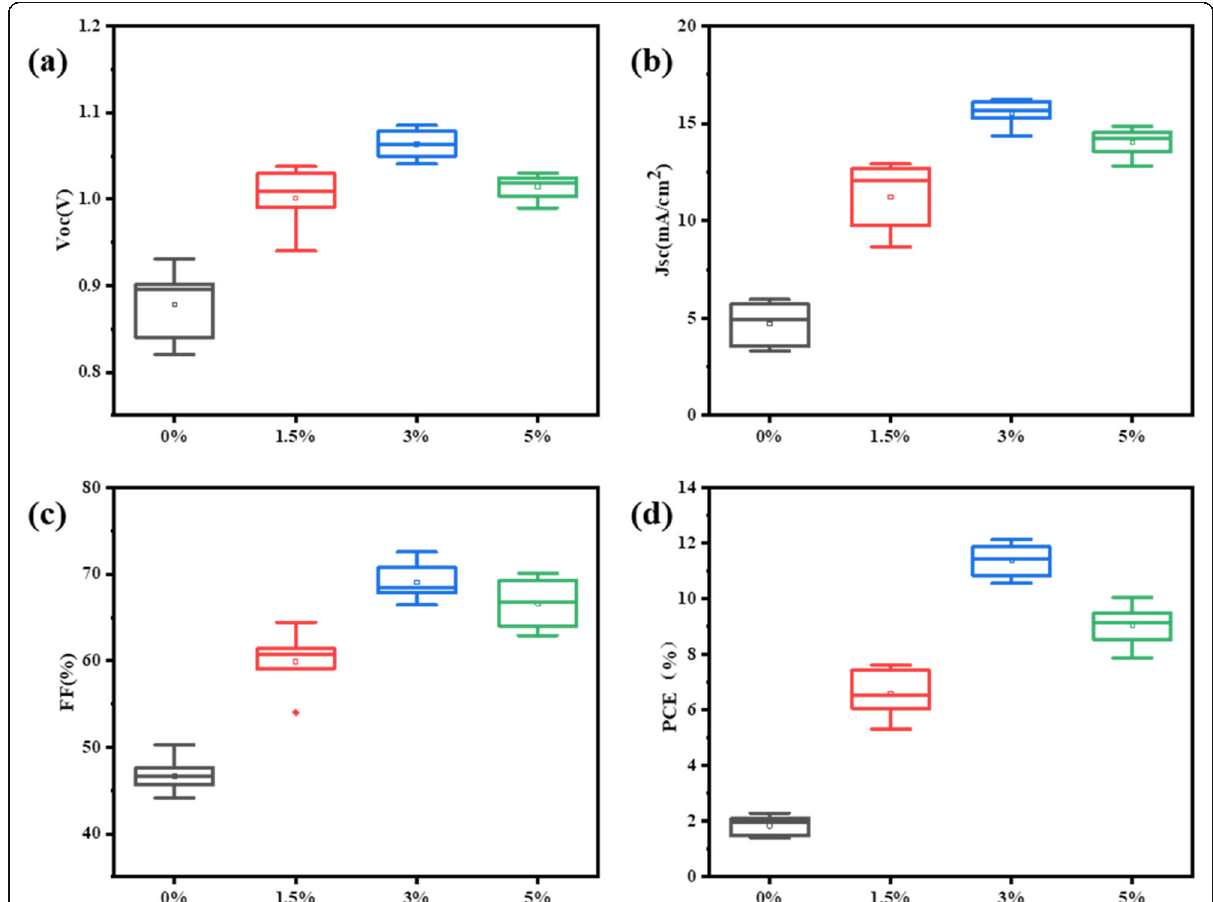
Fig. 2 Statistic distribution for ( a ) V oc , ( b ) J sc , ( c ) FF , and ( d ) PCE of 2D PVSCs based on BA 2 MA 3 Pb 4 I 13 films with various amounts of H 2 O